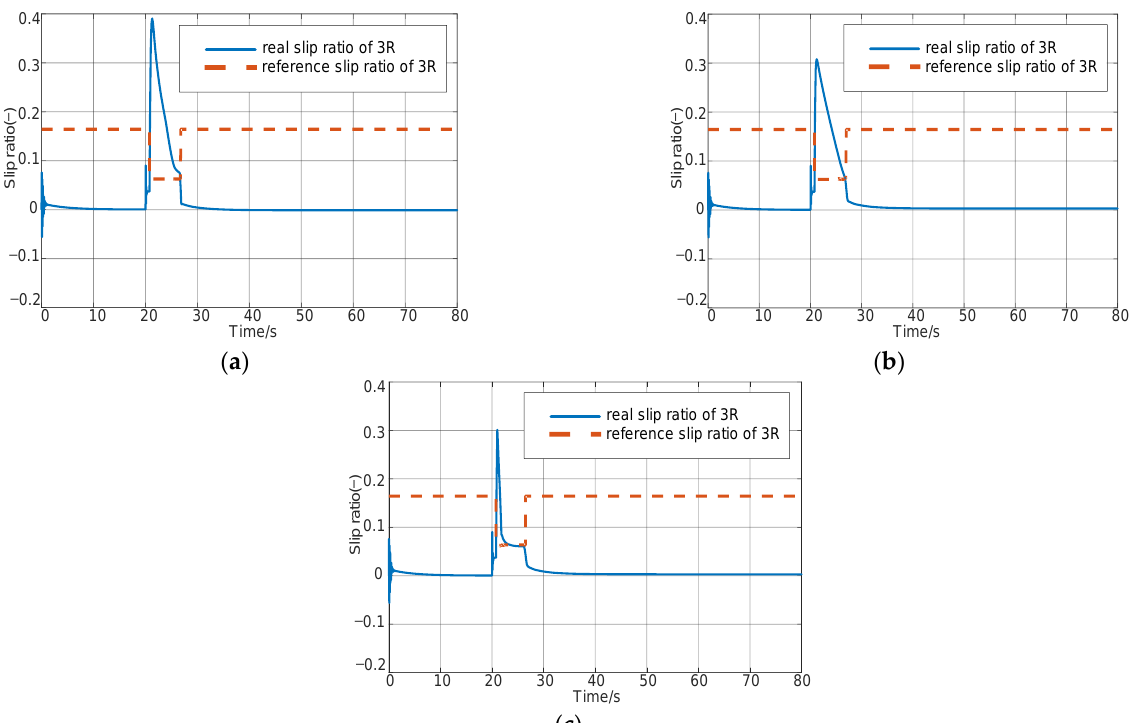
Figure 12. Slip ratio of the right wheel of the 3rd axle (3R) on the split road surface controlled by the ( a ) PID method, ( b ) SMC, and ( c ) HLQR.